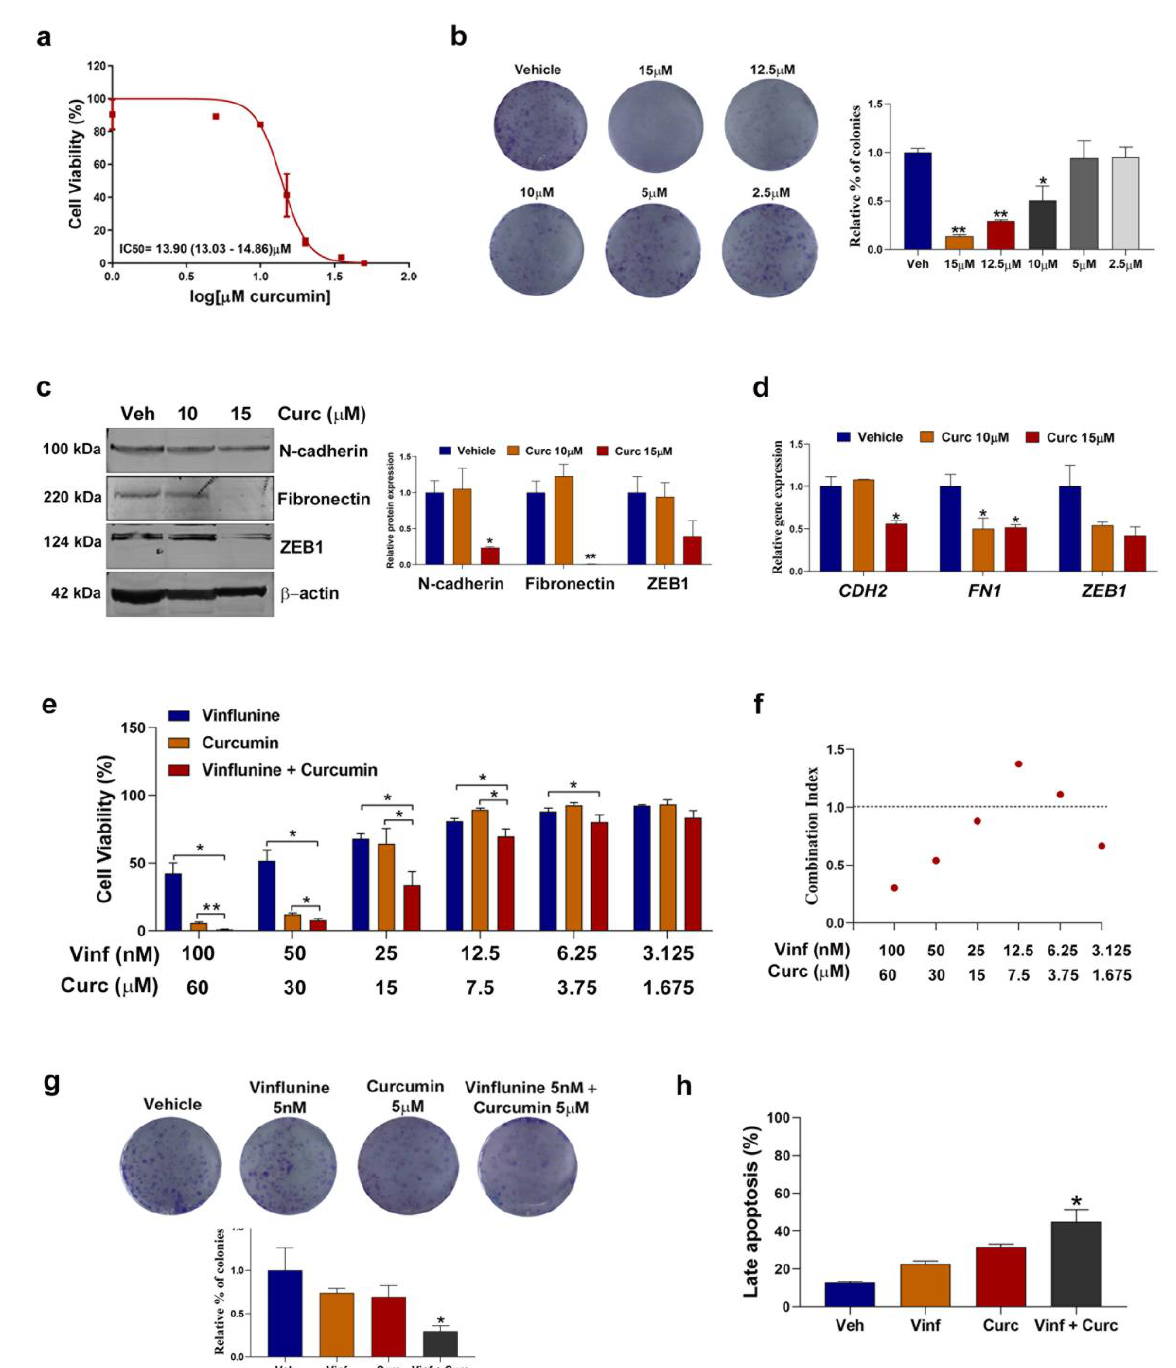
Figure 5. Curcumin treatment downregulated EMT markers and enhanced vinflunine sensitivity in T24 cells. ( a ) Dose– response curve for T24 cells after curcumin treatment at 0–50 µ M for 72 h (mean ± SEM). IC50 value is shown as mean (95% CI). ( b ) Representative colony assay images (left) and bar graph (right) representing the percentage (mean ± SEM) of colonies in T24 cells after curcumin treatment for 72 h at the indicated doses. * p < 0.05 and ** p < 0.01 relative to vehicle. ( c ) Western blot analysis (left) and graphic representation (right) of N-cadherin, Fibronectin and ZEB1 in T24 cells after curcumin treatment for 72 h. Beta-actin was used as endogenous control. * p < 0.05 and ** p < 0.01 relative to the vehicle. ( d ) Bar graph illustrating relative gene expression levels (mean ± SEM) of N-cadherin ( CDH2 ), Fibronectin ( FN1 ) and ZEB1 after 72 h curcumin treatment at the indicated doses. Gene expression levels of β –actin ( ACTB ) were used as endogenous control. * p -value < 0.05 relative to vehicle condition. ( e ) Bar graphs representing mean ± SEM percentage of cell